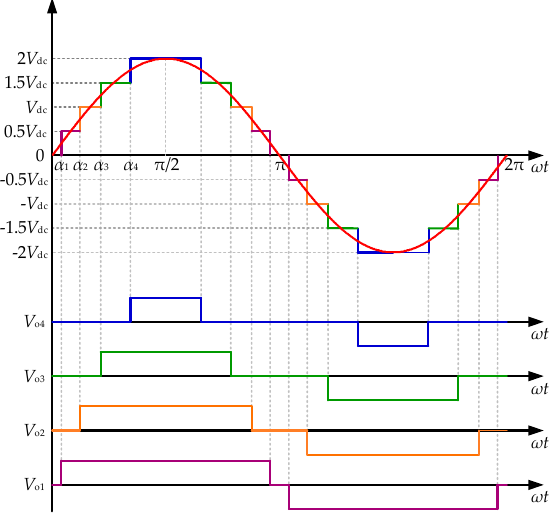
Figure 6. Schematic diagram of the ladder wave equal pulse width modulation (EPWM) .